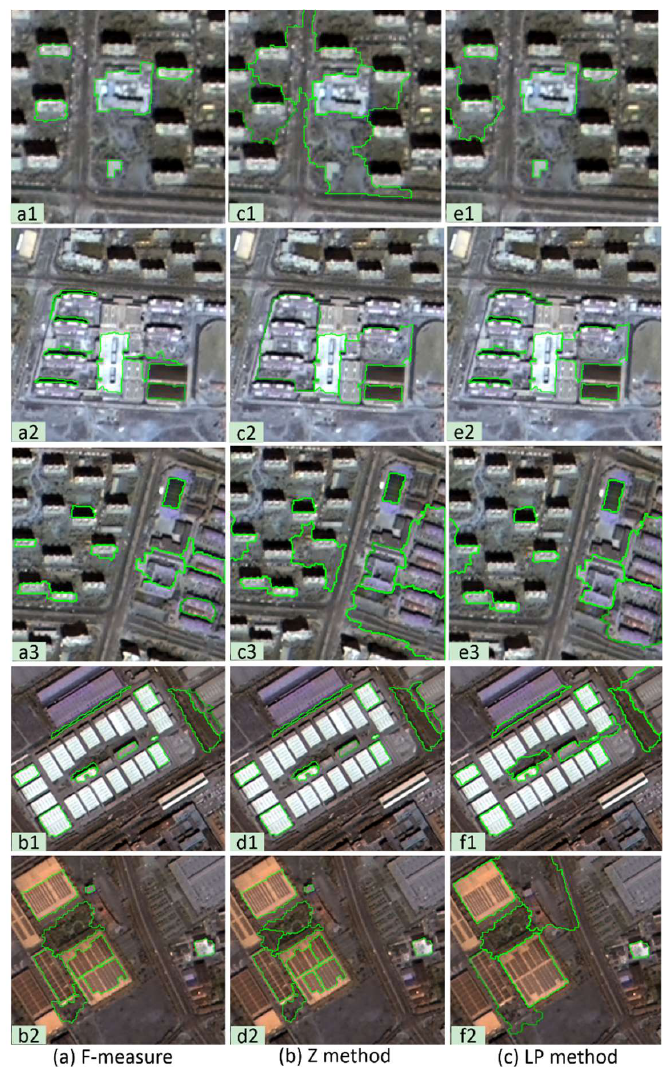
Figure 8. Subsets of the segmentation results in Figure 7, which are the F-measure, Z and LP results from left to right.